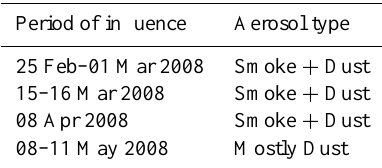
Table 4. Periods of influence of African particle advection from Feb to May 2008, reported by Baars et al.